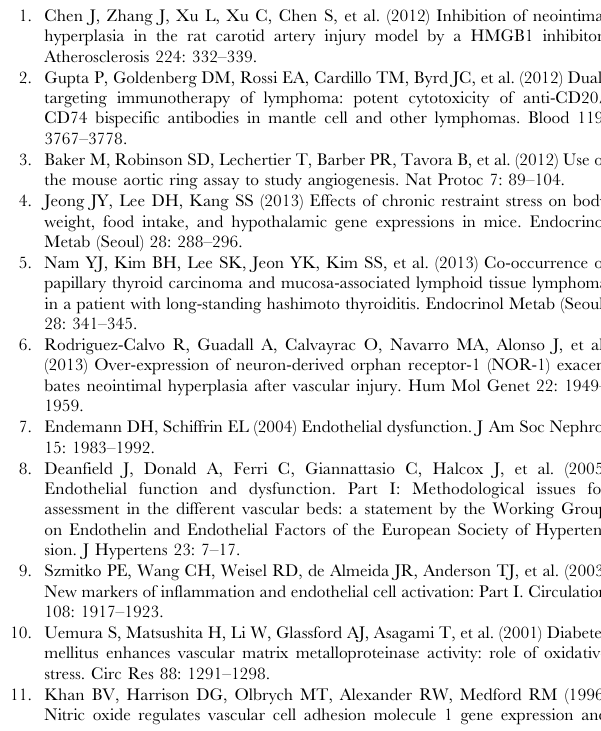
Figure S1 PCA’s inhibition on VSMC cell proliferation.